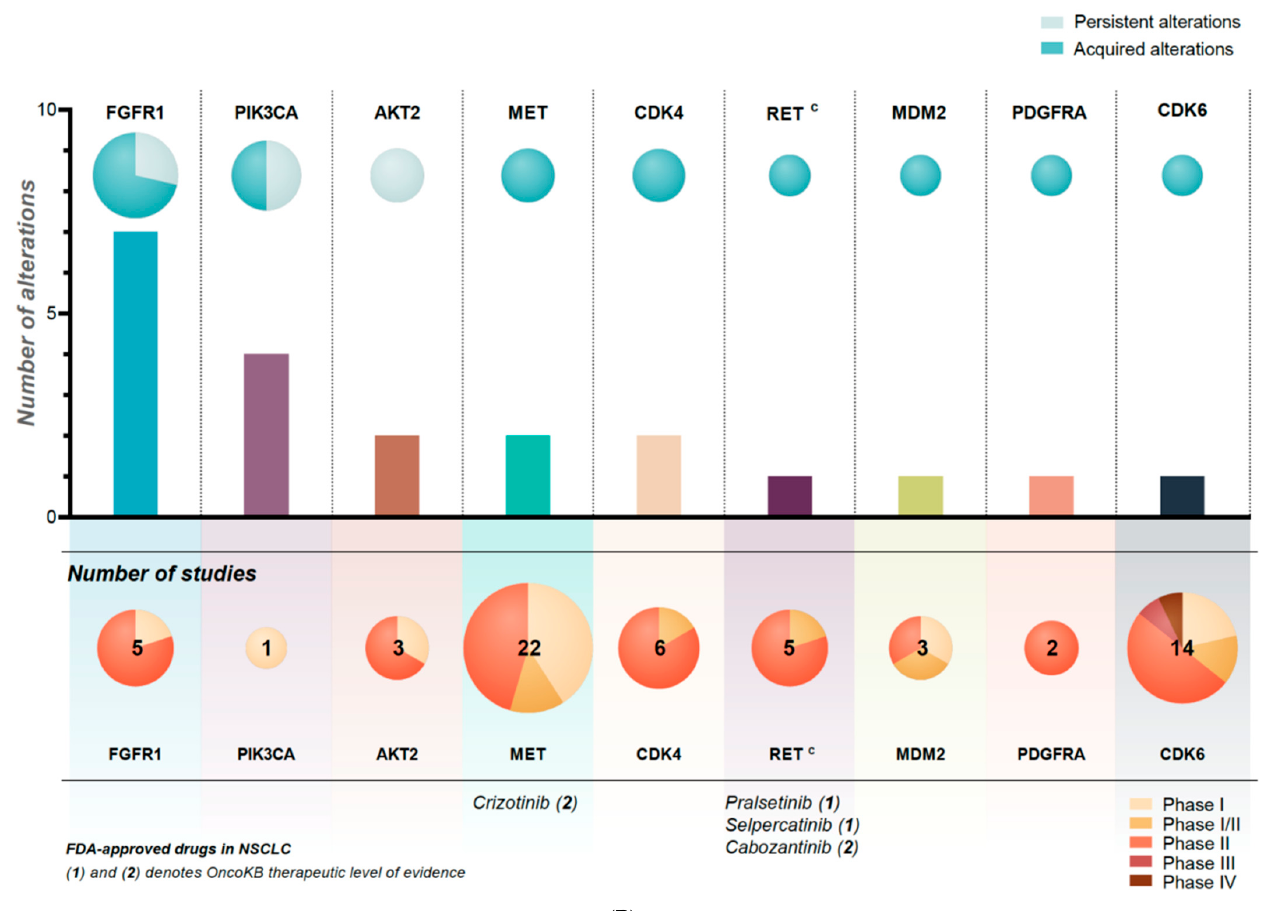
Figure 3. ( A , B ) Top illustrates the distribution of persistent and acquired actionable molecular al- terations (AMAs) in all the AMAs and in all the re-biopsied patients. Middle shows the frequencies and protein/transcript variants of the different mutations ( A )/amplifications ( B ) including the dis- tribution of persistent and acquired mutations. c denotes fusion. XX ^ represents different alterations occurring one time. * denotes stop codon. Bottom illustrates the corresponding number of recruiting studies available including the respective phases and FDA-approved drugs in